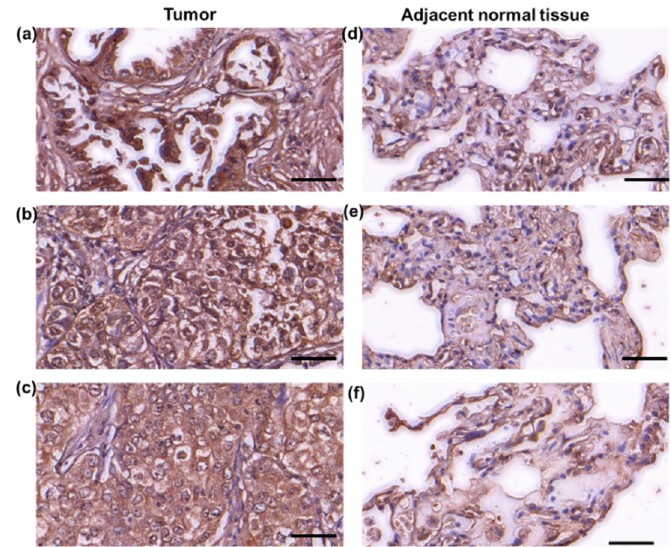
Figure 1. Increased RPIA expression was detected in the tumor biopsies of lung adenocarcinoma patients. Immunohistochemical staining was performed with anti-RPIA antibody on the lung adenocarcinoma tumor tissue arrays. ( a – c ) The adenocarcinoma grade 2 tumor tissues from 3 different lung adenocarcinoma patients, ( d – f ) the adjacent normal lung tissues from the same 3 patients in ( a – c ), respectively. Scale bar represents 50 μ m.